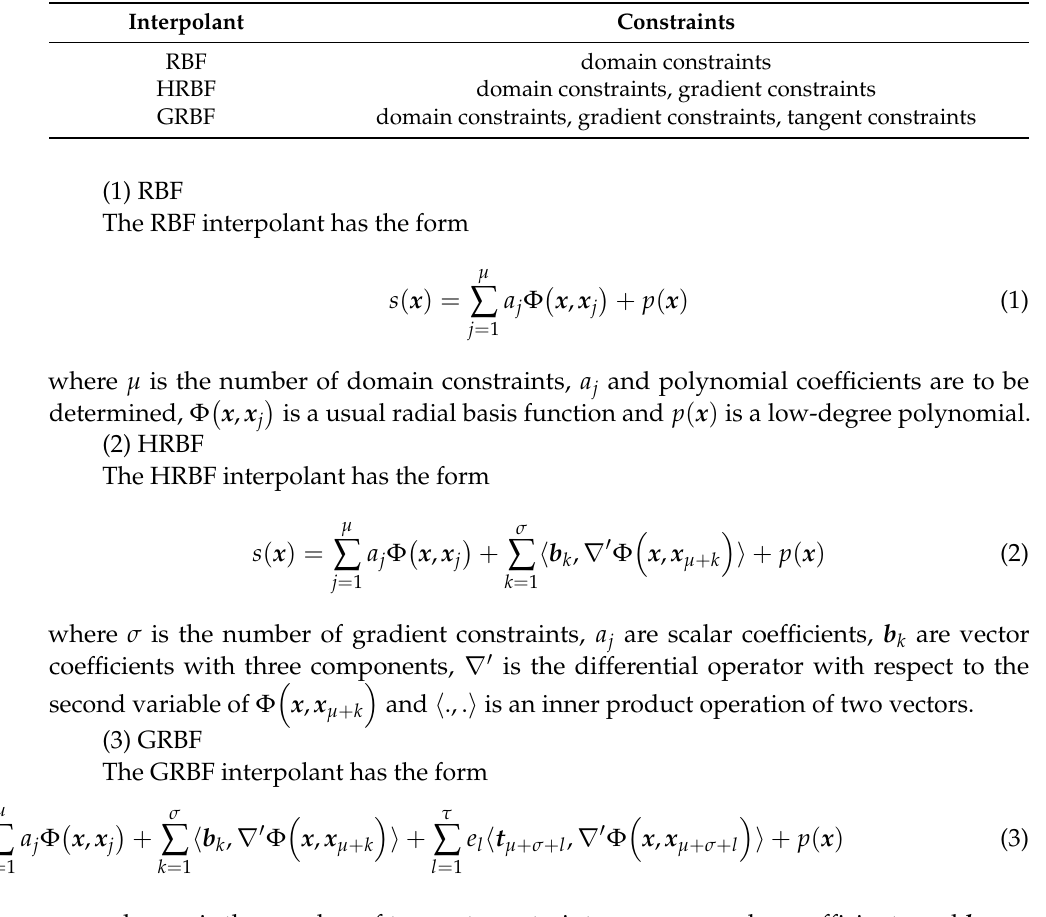
Table 1. The RBF-based interpolation